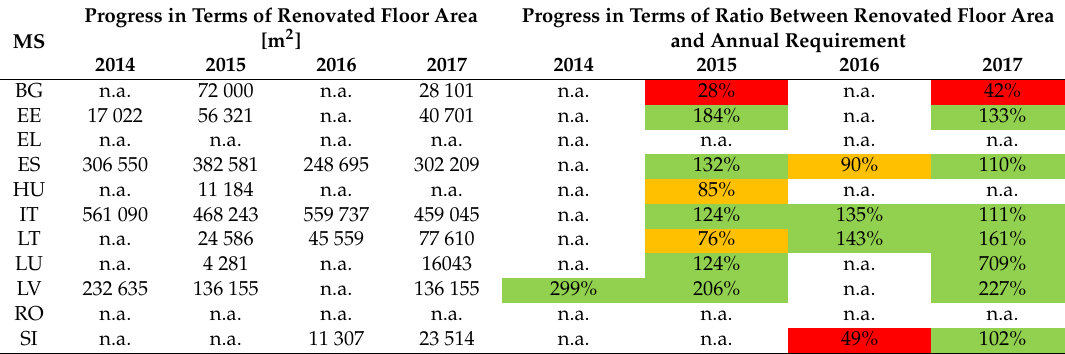
Table 5. Implementation progress of Article 5 requirement for Member States which chose the default approach (Art. 5(1)). Data are currently under